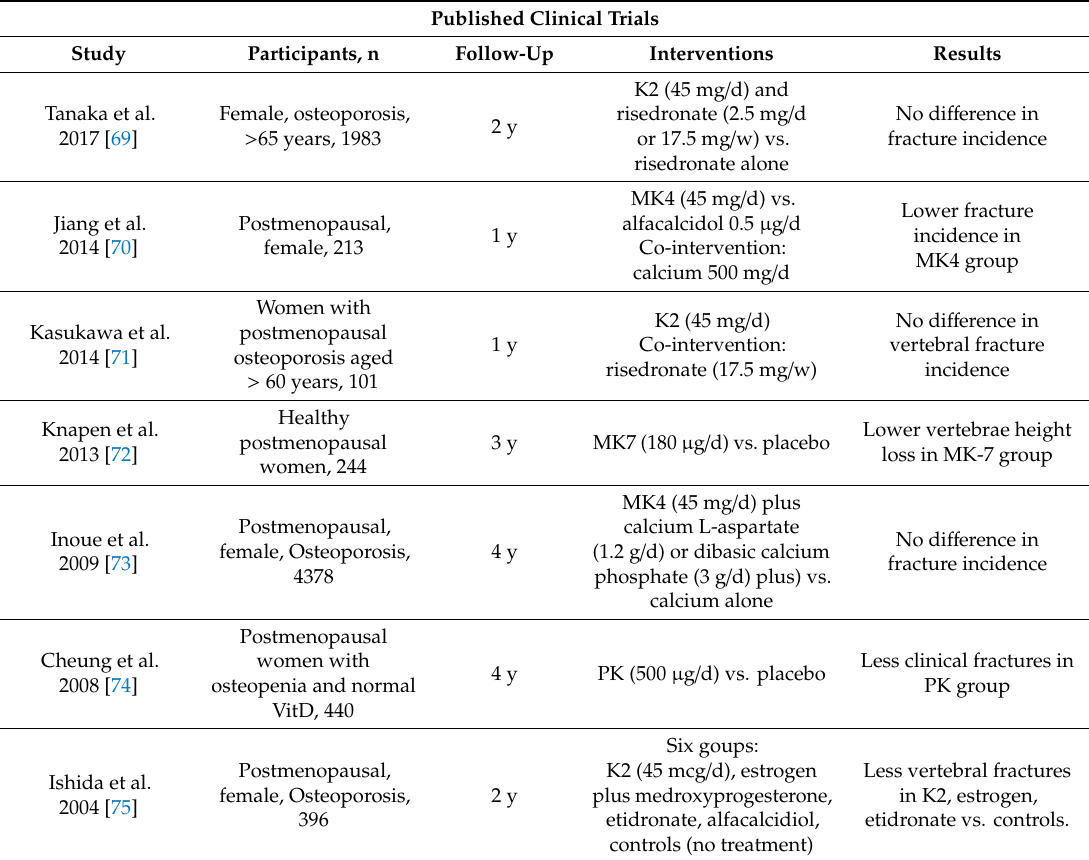
Table 1. Published and ongoing randomized controlled trials on the relationship between vitamin K and bone fractures having fractures as pre-specified outcome. Abbreviations: PK and K2, vitamin PK and K2; MK4, menaquinone 4, MK7, menaquinone 7; RCT, randomized clinical trial; DB, double blind; ESRD, end-stage renal disease; HD, hemodialysis; PD, peritoneal dialysis; d, day; m, month; w, week; y, year; CAC, coronary artery calcification; AUs, Agatson